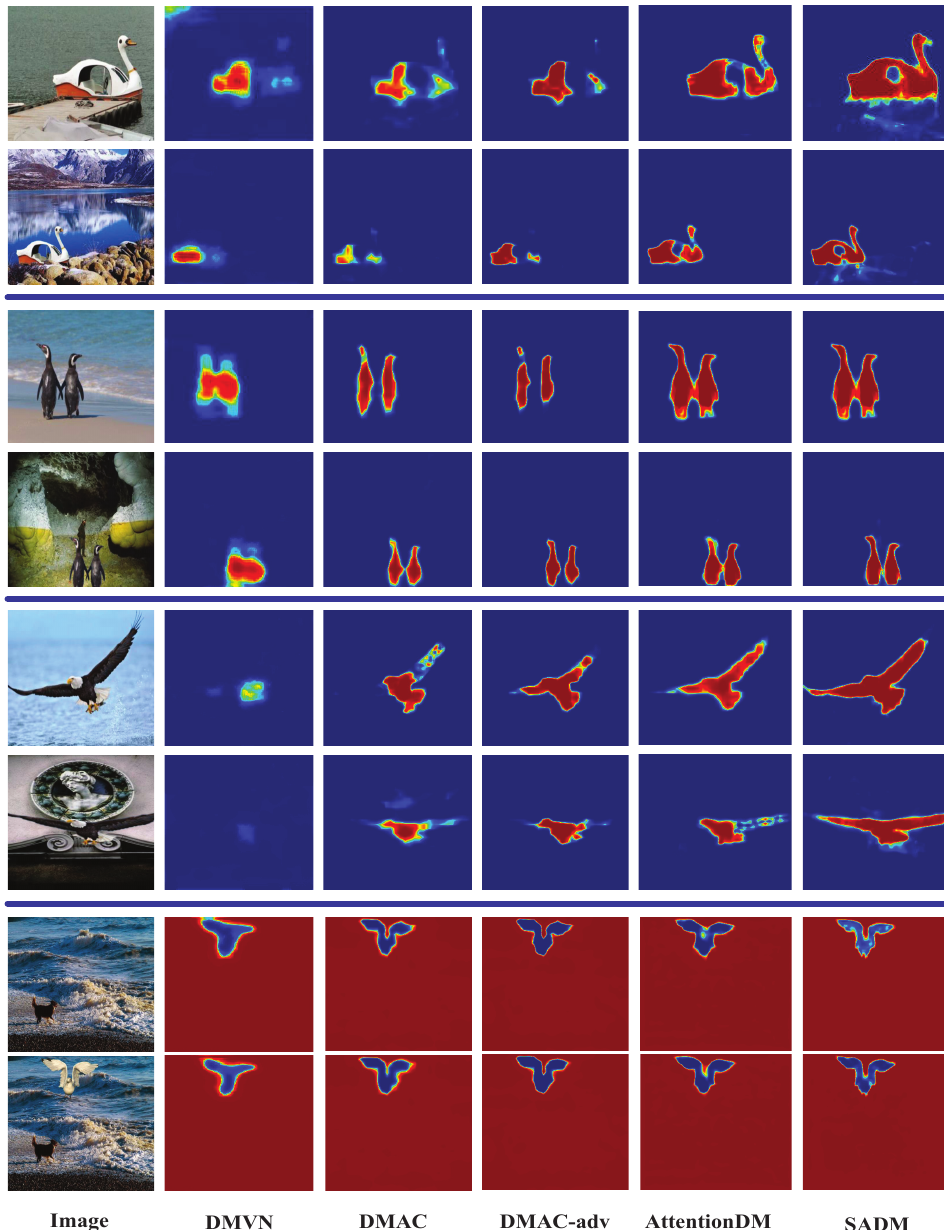
Figure 7. Visual comparisons on the paired CASIA